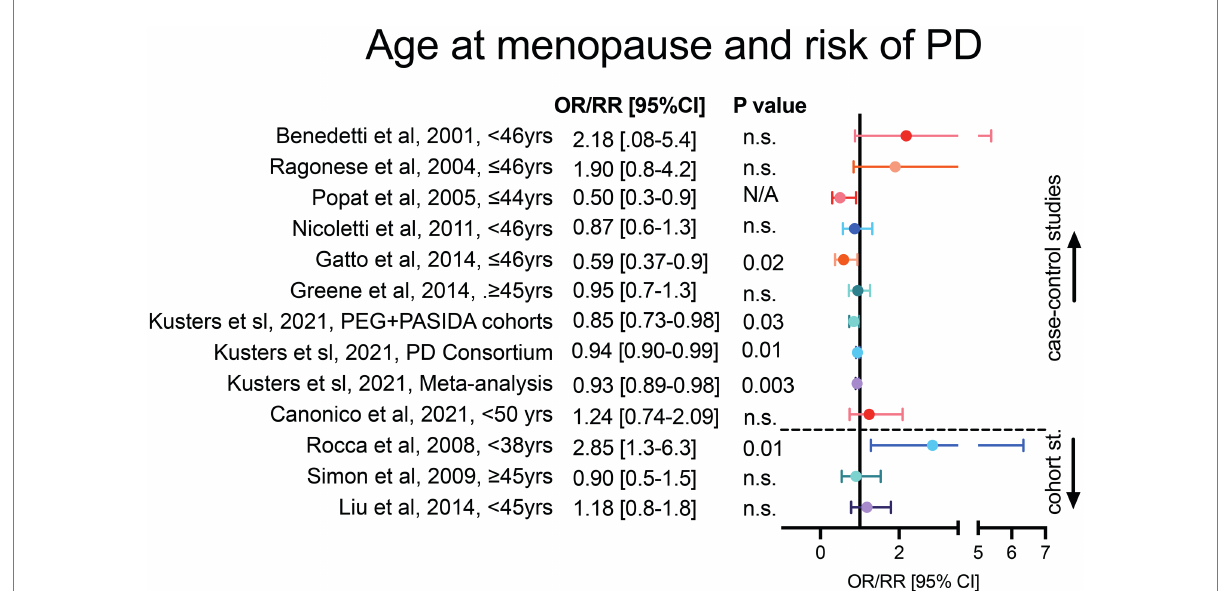
FIGURE 1 Age at menopause and risk of PD onset. Case–control studies in the upper section and cohort studies in the lower section of the forest plot are represented. For each study, figure reports adjusted OR/RR and 95% CI with level of statistical significance ( p value). OR = odds ratio, RR = relative risk, 95% CI = 95% confidence of